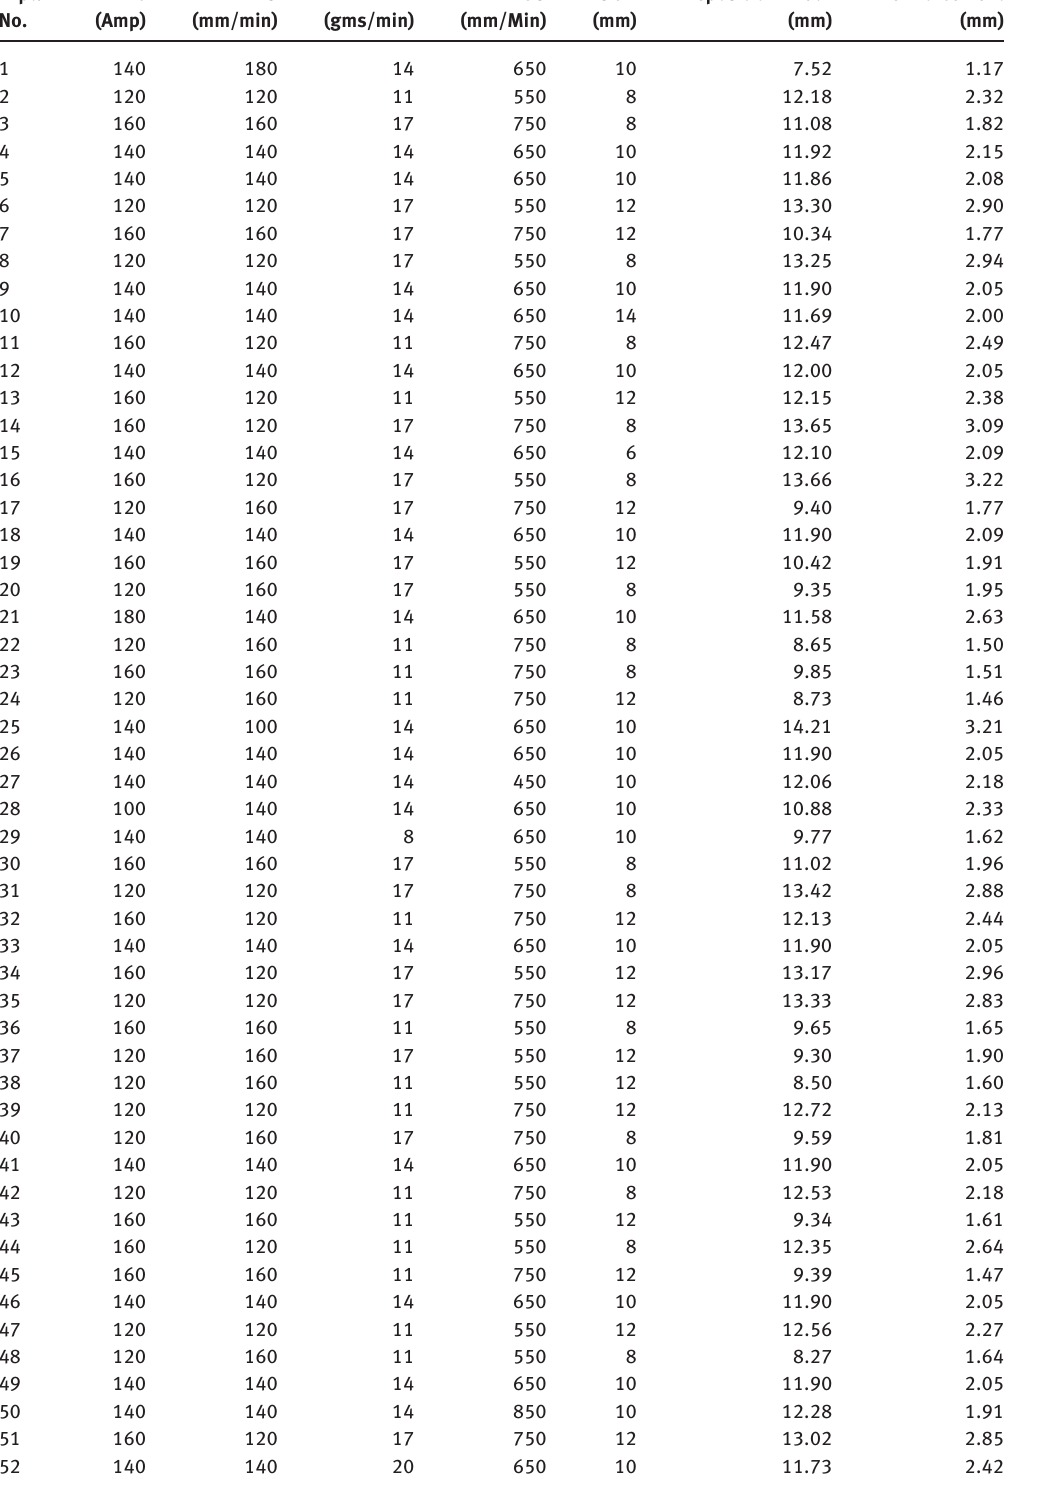
Table 3: Design of experiment along with measured responses.